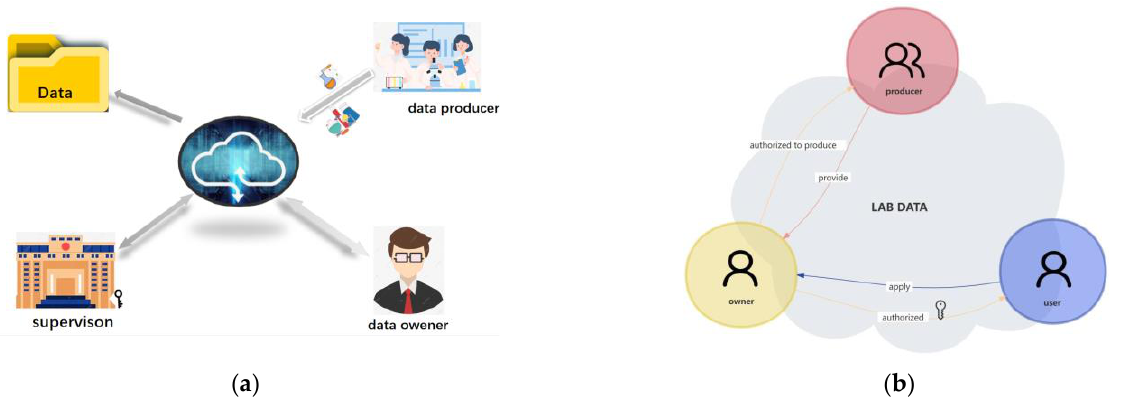
Figure 2. Illustrates the relationship of data-related persons or branches ( a ) and the relationship between data user, producer, and owner ( b ).